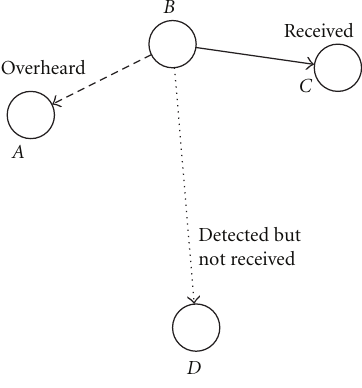
Figure 1: Implicit versus explicit data. Node B transmits a message for node C . Nodes A and C each detect and receive it (the message is intended for C , but A has overheard it). The detection provides an implicit range estimate to node B ; the reception provides all of the explicit routing information contained in the message (e.g., in the source route). Node D detects but does not receive the message, thus D gains an implicit range estimate to node B but gets none of the explicit data.